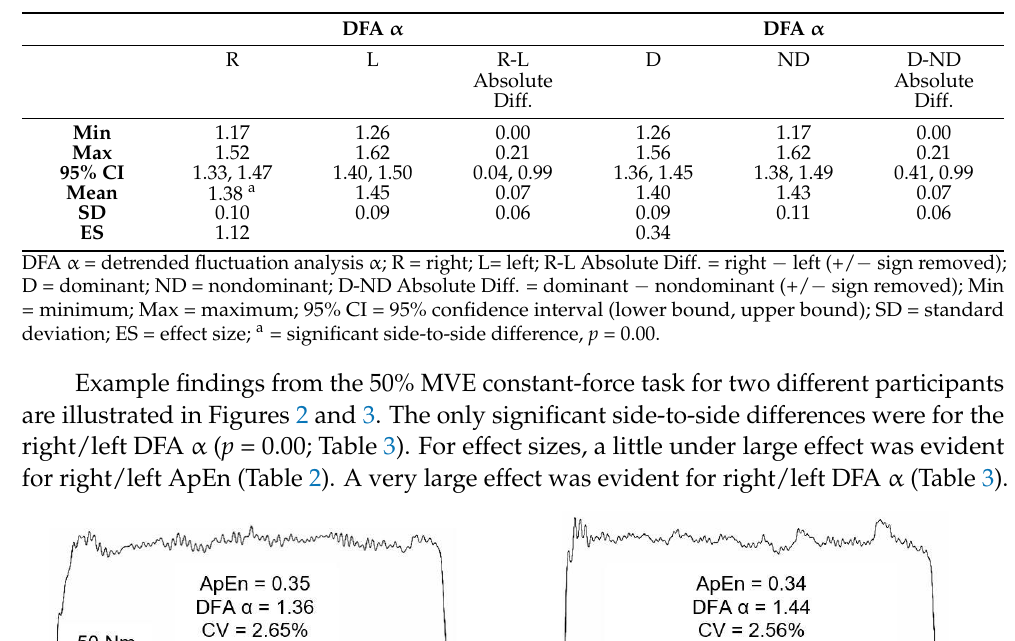
Table 3. Summary statistics and effect sizes for detrended fluctuation analysis α ( n = 16).